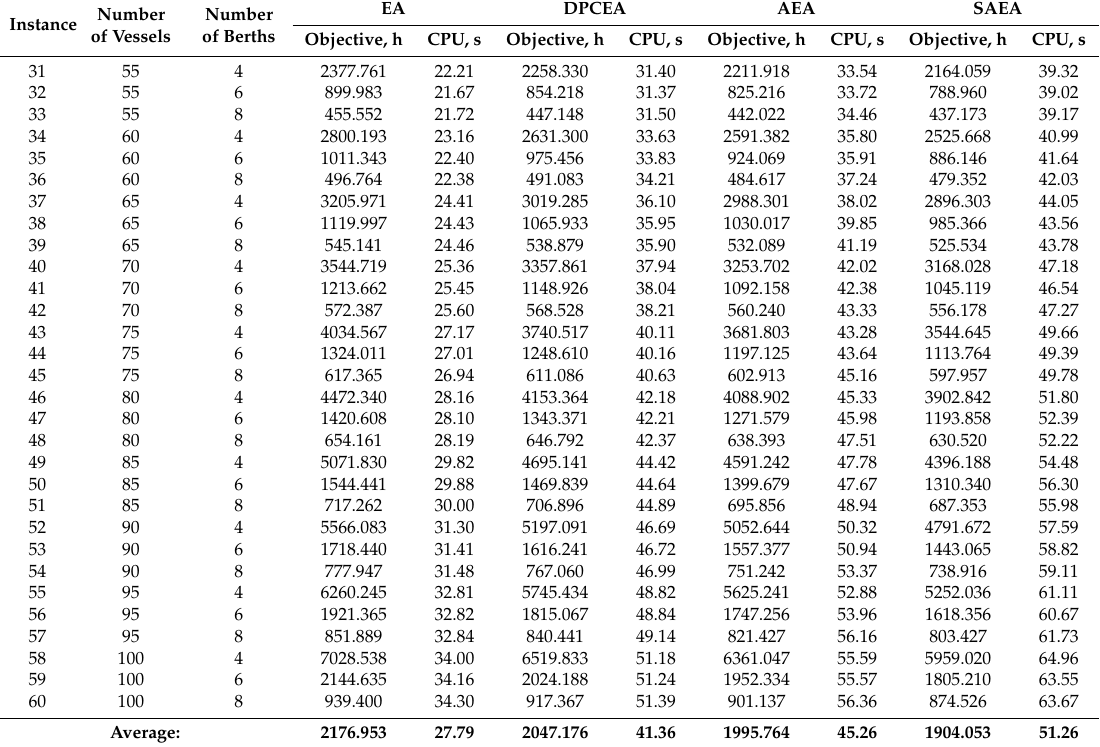
Table 5. The objective function and computational time values for the developed solution algorithms and large size problem